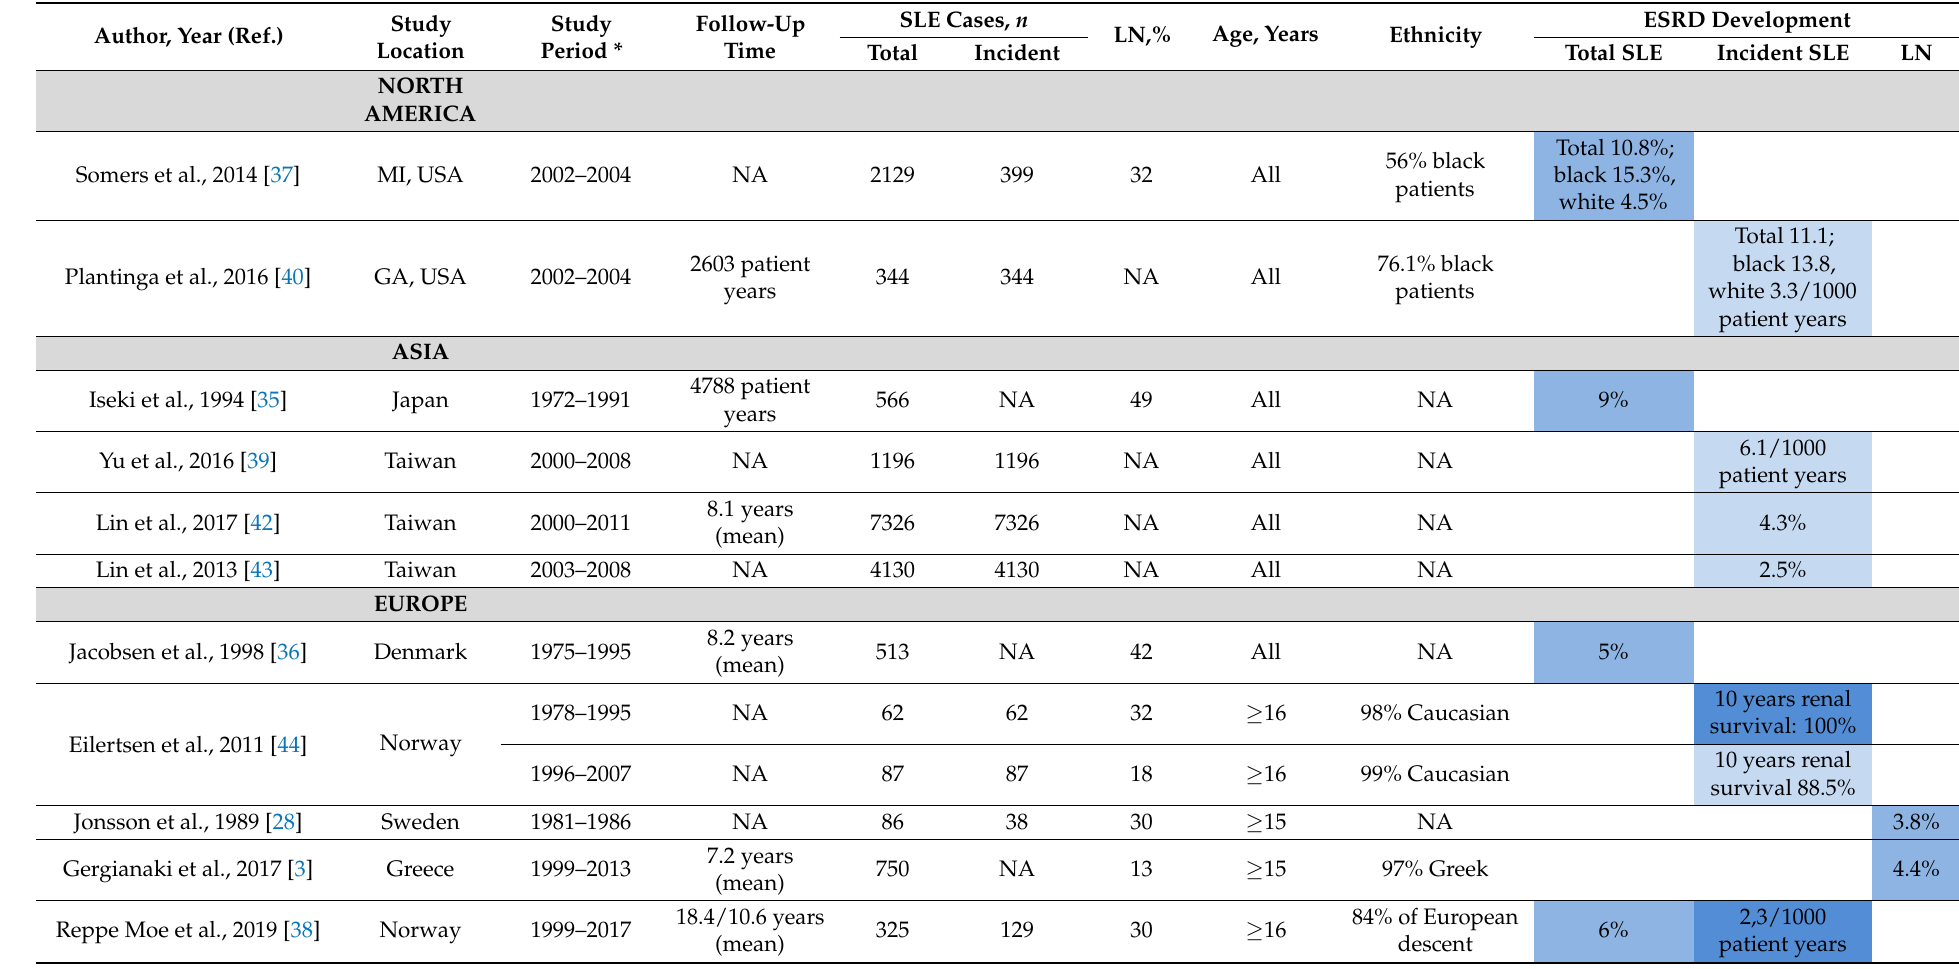
Table 4. Risk of End Stage Renal Disease in Systemic Lupus Erythematosus, from population-based